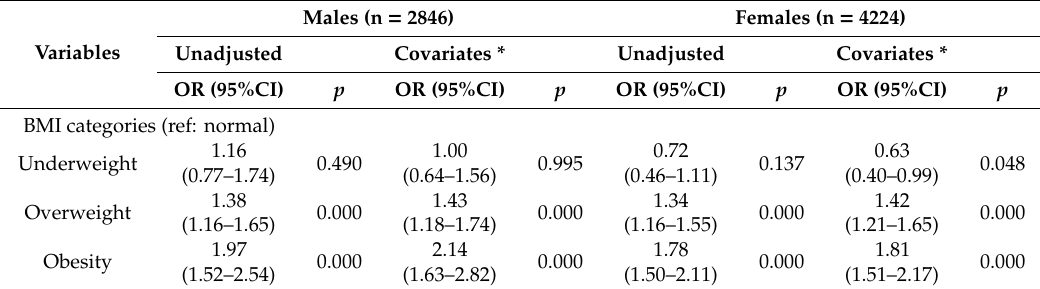
Table 3. Multivariate logistic regression of BMI categories associated with the prevalence of multimorbidity in male and female older